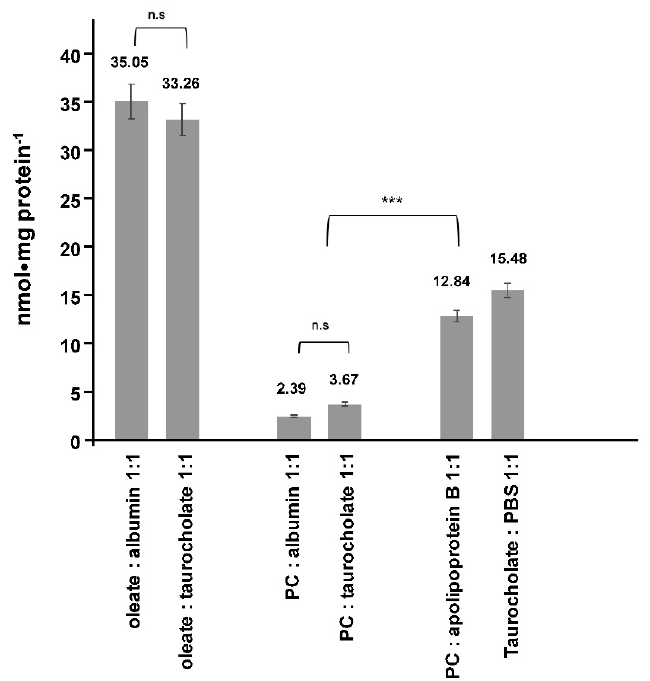
Figure 3. Intracellular accumulation of phosphatidylcholine (PC), fatty acids and taurocholate (TC) in non-polarized Mz-ChA-1 cells. After 1 h incubation of the different substrates with various binding molecules at 37 °C, the amount taken up by the cells was determined after washing the cells three times with 10 mM TC in phosphate-buffered saline (PBS). Means ± SD of n = 6; n.s. = not significantly different, *** p < 0.001.